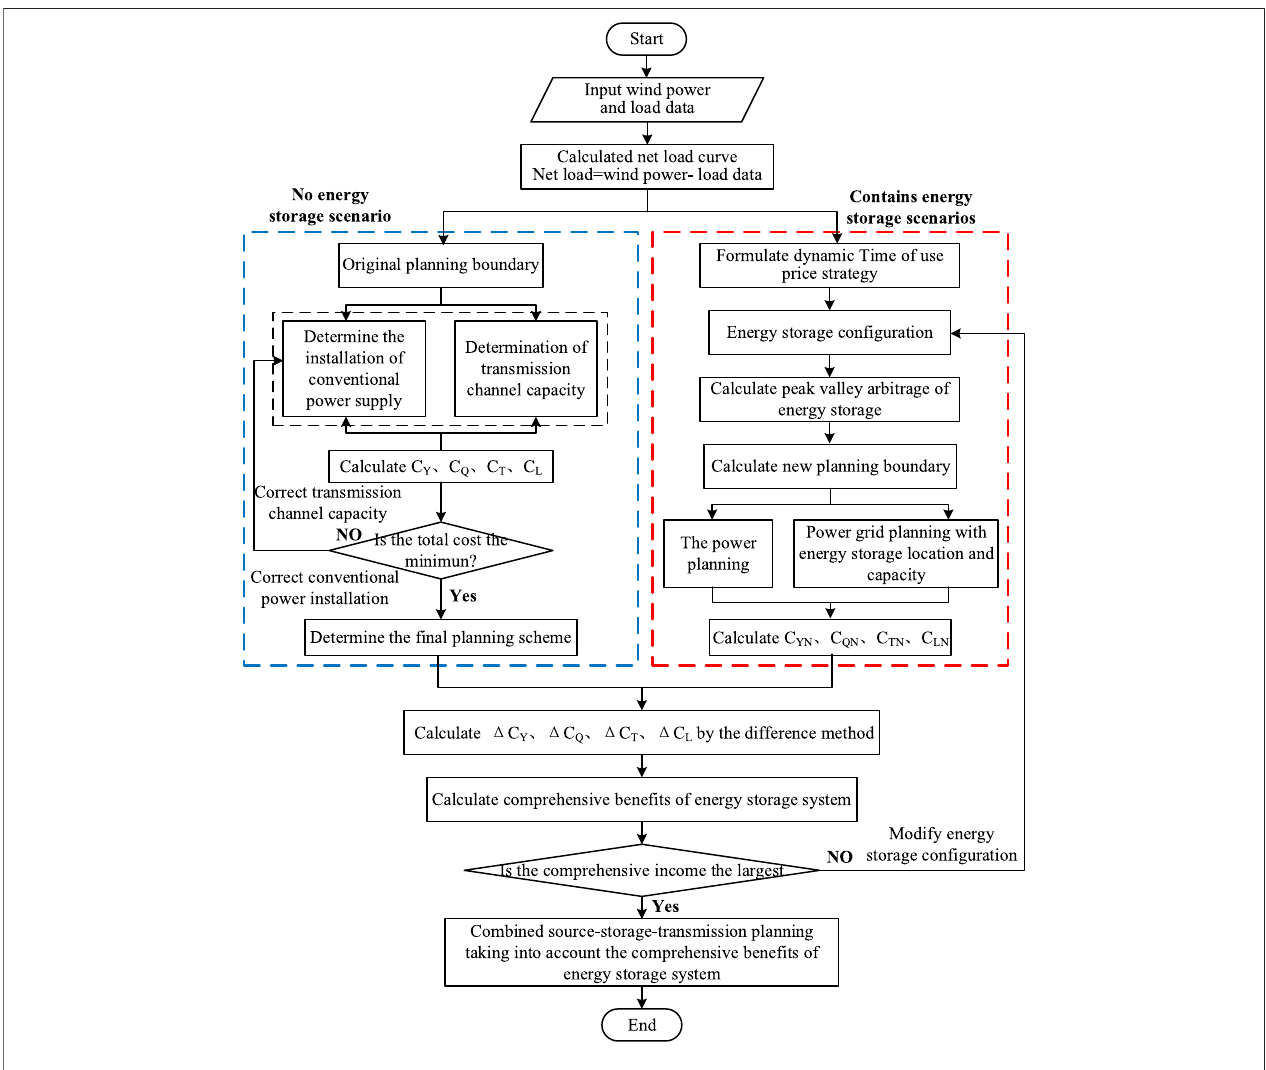
FIGURE 5 | Schematic block diagram of the source-storage-transmission coordinated planning method considering comprehensive incomes of energy storage.